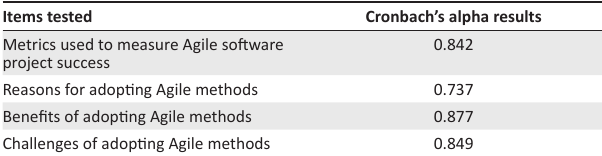
TABLE 1: Reliability test and